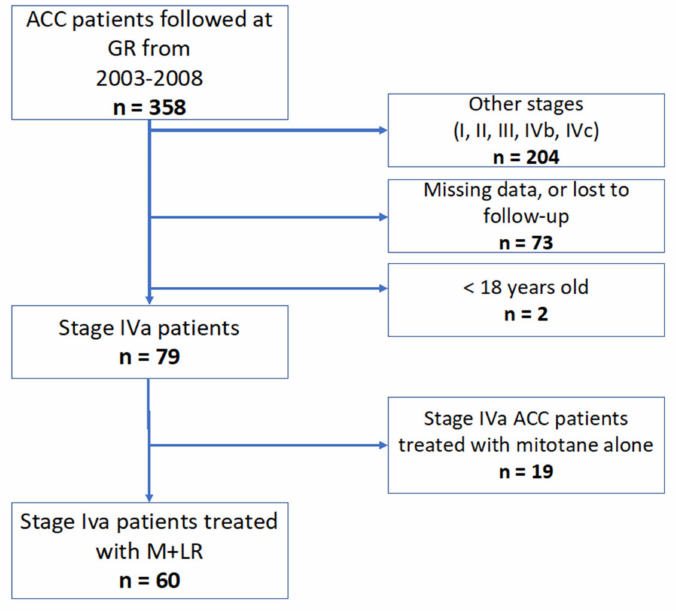
Figure 1. Flow-chart. ACC: adrenocortical carcinoma; GR: Gustave Roussy. Table 1. Patient and tumor characteristics at stage IVa